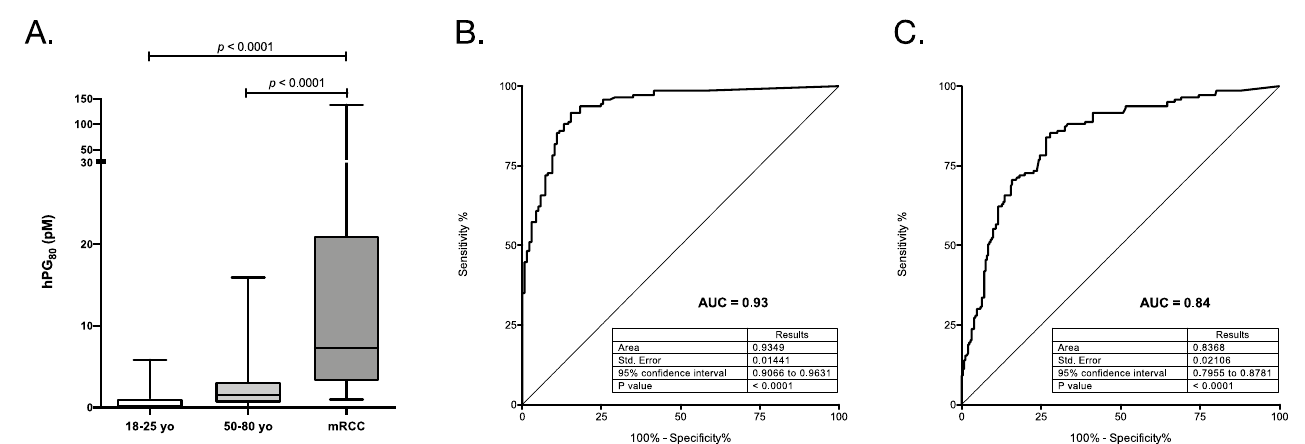
Figure 2. Levels and performances of plasma hPG 80 in patients with mRCC patients. ( A ) hPG 80 concentrations in mRCC patients ( n = 143) compared to 18–25 ( n = 137) and 50–80 ( n = 252) years old control groups. Two-tailed Mann-Whitney test. B to C. Diagnostic discriminative accuracies of hPG 80 in mRCC patients compared to control groups aged 18–25 year old ( B ) or 50–80 year old ( C ) using Receiver Operating Characteristics (ROC) curve analysis. Table 2. hPG 80 levels in mRCC patients and in control cohorts. <LoD: hPG 80 levels were below the limit of detection (LoD). Characteristics Patients